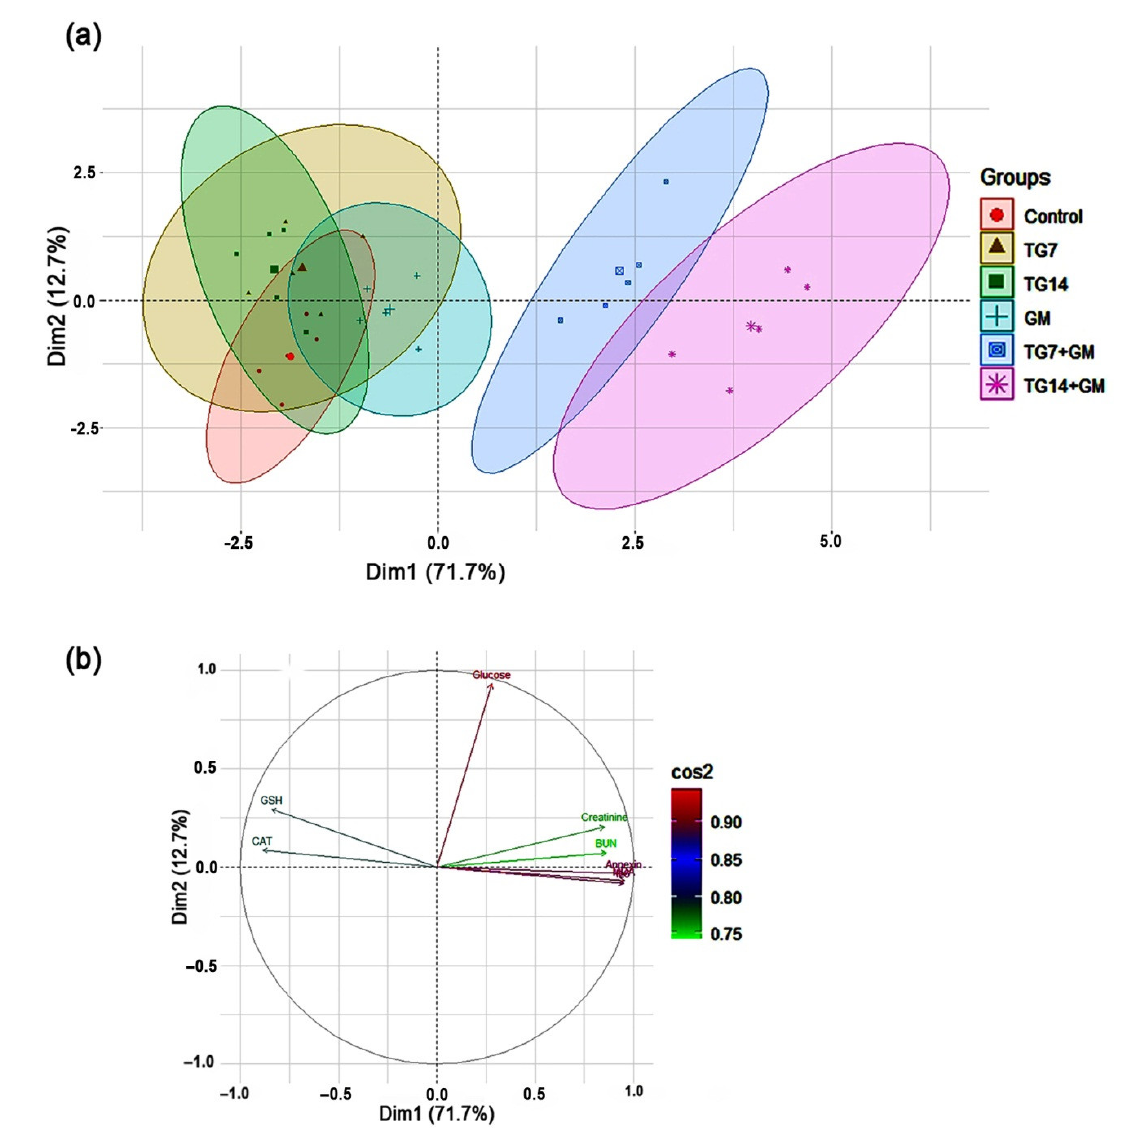
Figure 6. The principal component analysis (PCA) biplot. ( A ) The PCA for thirty treated rats, the control (red circles, n = 5), TG7 (tigecycline, 7 mg/kg; n = 5; yellow triangles), TG14 (tigecycline, 14 mg/kg; n = 5; green squares), GM (gentamicin; n = 5; blue pluses), TG7+GM ( n = 5; blue squares), and TG14+GM ( n = 5; pink asterisks). Percentage values indicated on the axes represent the contribution rate of Dim1 and 2 to the total amount of variation. ( B ) The contribution degree of the different variables. The colored scale indicates that the strength of the contribution ranged from the highest (red color) to lowest contribution (green color).